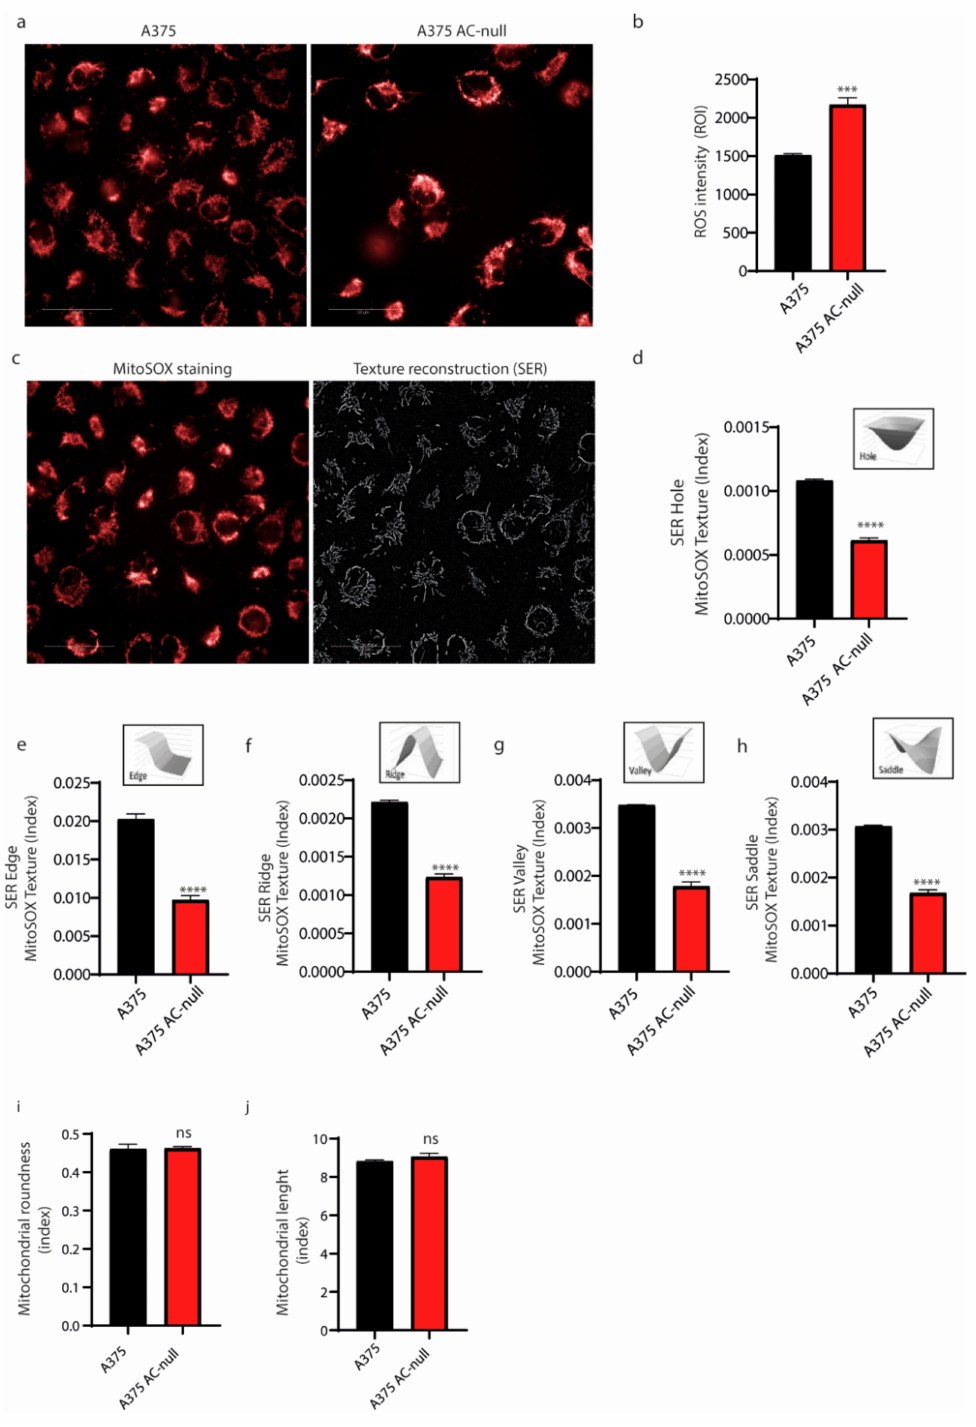
Figure 5. Mitochondria organization in A375 AC-null cells. ( a ) Mitochondrial membrane potential staining with MitoSOX dye was analyzed by high-content confocal screening using 40 × water objectives, scale bar: 50 µ m. ( b ) MitoSOX intensity analysis on both cell lines revealed increased ROS accumulation in A375 AC-null cells. Seventy-two fields were analyzed in three technical and biological triplicates. Data are expressed as mean ± SD, statistical analysis was performed using Student’s t- test, *** p < 0.0001. ( c ) Representative image of SER segmentation of MitoSOX mitochondria staining. ( d – j ) SER segmentation analyses performed using Student’s t- test on morphological properties of mitochondria in A375 and A375 AC-null cells. The analysis revealed profound alterations of mitochondria structure and shape in A375 AC-null cells compared to their WT counterparts ( d – h ). The roundness and length of single mitochondria remained unchanged ( i , j ). **** p < 0.00001; ns = not statistically